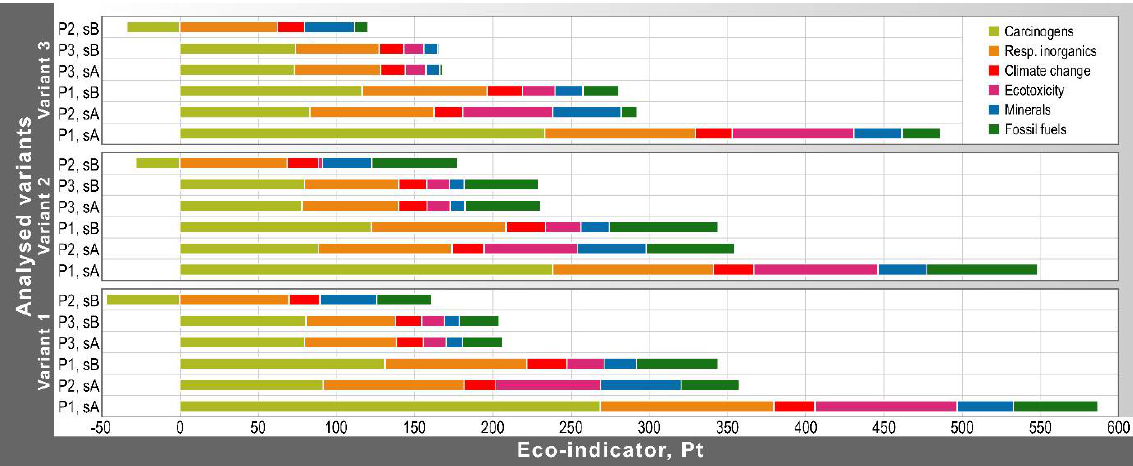
Figure 4. Share of individual categories of inflows in eco-indicator points.